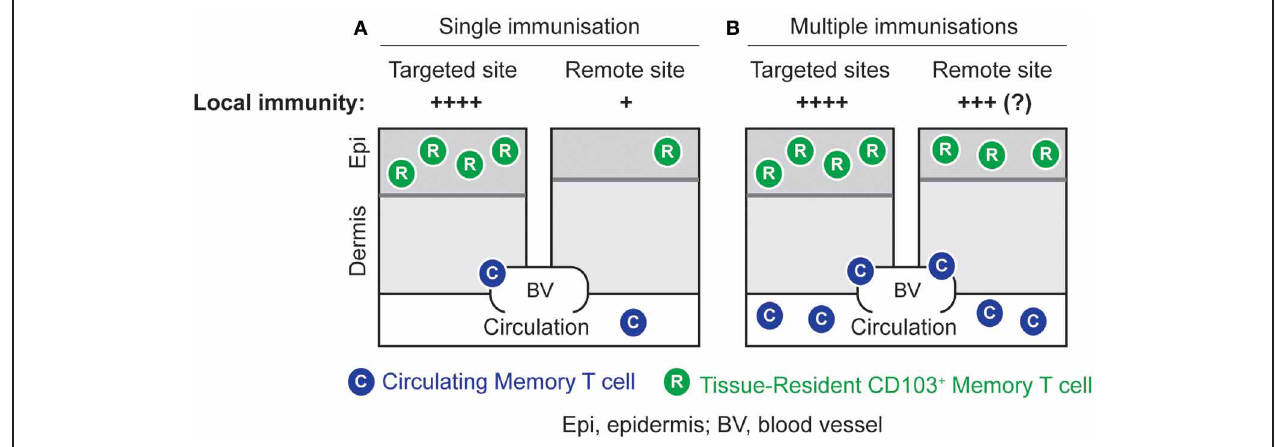
FIGURE 2 | Local immunity by site-specific or global lodgment of T RM cells. (A) High numbers of T RM cells can be generated in the skin by an immunization strategy that combines the induction of effector T cells with the local application of an inflammatory stimulus. This results in potent local immunity at the targeted site.